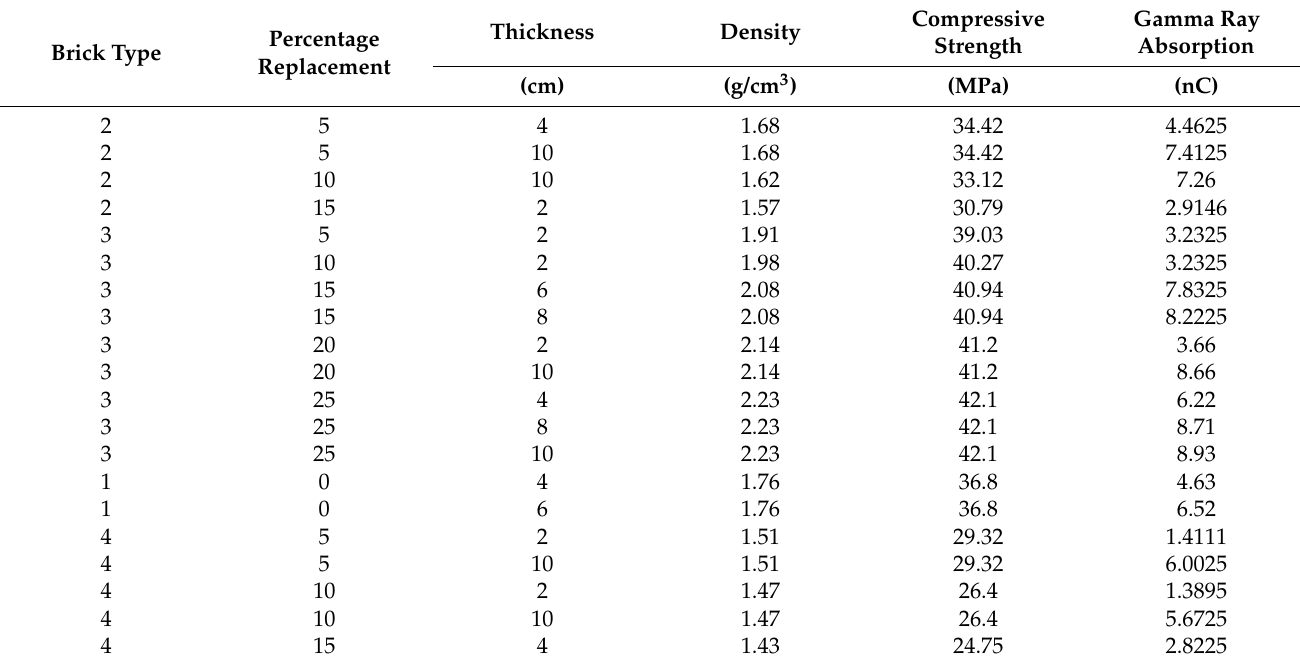
Table 7. Validation dataset for model development.